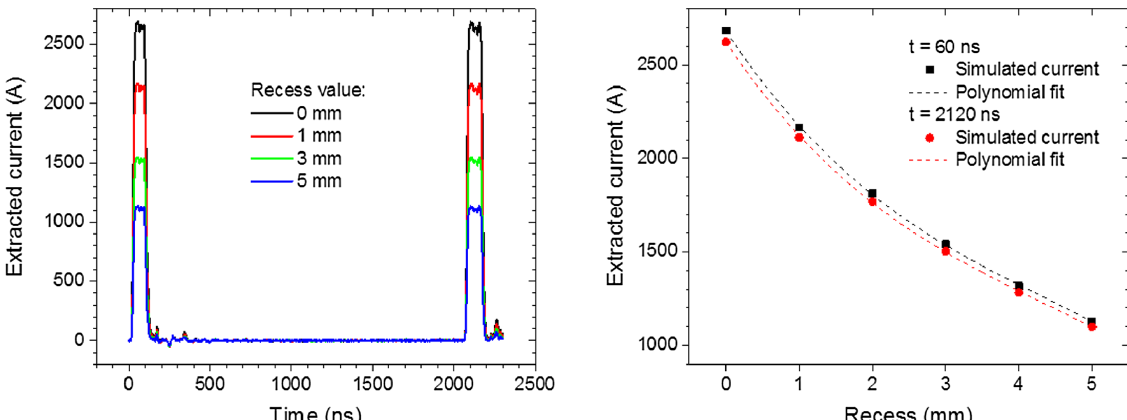
FIG. 5. Left: evolution of the extracted current for different recess values from 0 to 5 mm used in the simulation with a delay of 2 μ s between the two pulses. Right: evolution of the extracted current as a function of the recess value for the first pulse at t ¼ 60 ns (black square) and the second pulse at t ¼ 2120 ns (red circle). The dotted lines correspond to third-order polynomial